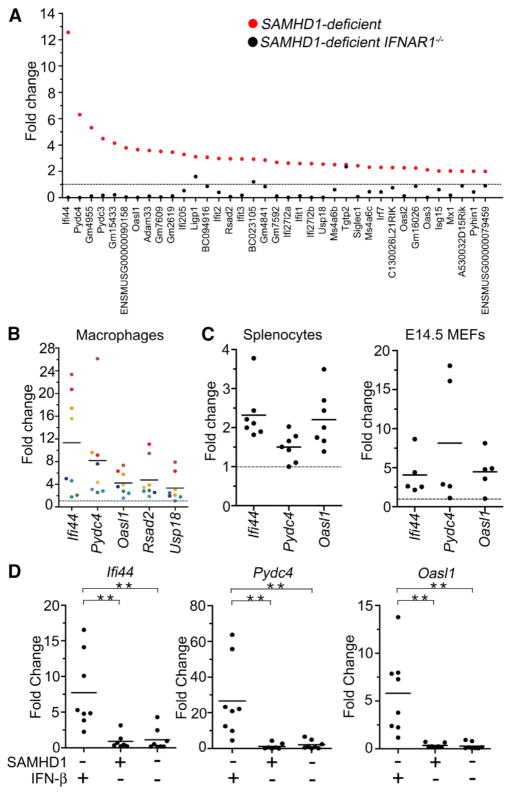
Spontaneous Induction of Type I IFN-Inducible Genes in SAMHD1-Deficient Cells(A) mRNA of FACS-sorted peritoneal macrophages from ten SAMHD1-defi-cient, ten SAMHD1-deficient IFNAR1−/−, and ten control mice was analyzed by Illumina-based transcriptome sequencing. In total, 37 genes were upregulated at least 2-fold (p < 0.05) in SAMHD1-deficient mice compared with controls. All but two of these genes were known to be inducible by type I IFN (displayed as red dots). In the comparison of SAMHD1-deficient IFNAR1− /− versus control cells, reduced transcript levels, rather than upregulation, were observed for most of these genes (black dots).(B) Transcript levels of five IFN-inducible genes found to be upregulated in the transcriptome analysis (A) were quantified in peritoneal macrophages from eight additional SAMHD1-deficient and 18 additional control mice by qRT-PCR. Fold upregulation for individual mutant samples compared with the mean of all control samples is displayed with colors identifying individual mice. (C) Transcript levels of three IFN-inducible genes were assessed in SAMHD1-deficient (n = 7) and control (n = 4) splenocytes, and in mutant (n = 5) and control (n = 4) E14.5 MEFs by qRT-PCR. Results are displayed as fold change for each mutant compared with the means of all controls. All genes were significantly upregulated (p < 0.04) in all mutant samples analyzed.(D) Transcript levels of three IFN-inducible genes in peritoneal macrophages from SAMHD1Δ/Δ IFN-β-deficient (n = 8), SAMHD1Δ/Δ IFN-βcompetent (n = 8), and SAMHD1WT/WT IFN-β-deficient (n = 8) mice as determined by qRT-PCR. Results are displayed as fold change for each individual sample compared with the mean of all WT control samples (n = 8).See also Figure S3.